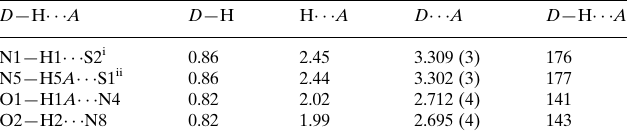
Hydrogen-bond geometry (A˚ , (cid:2)